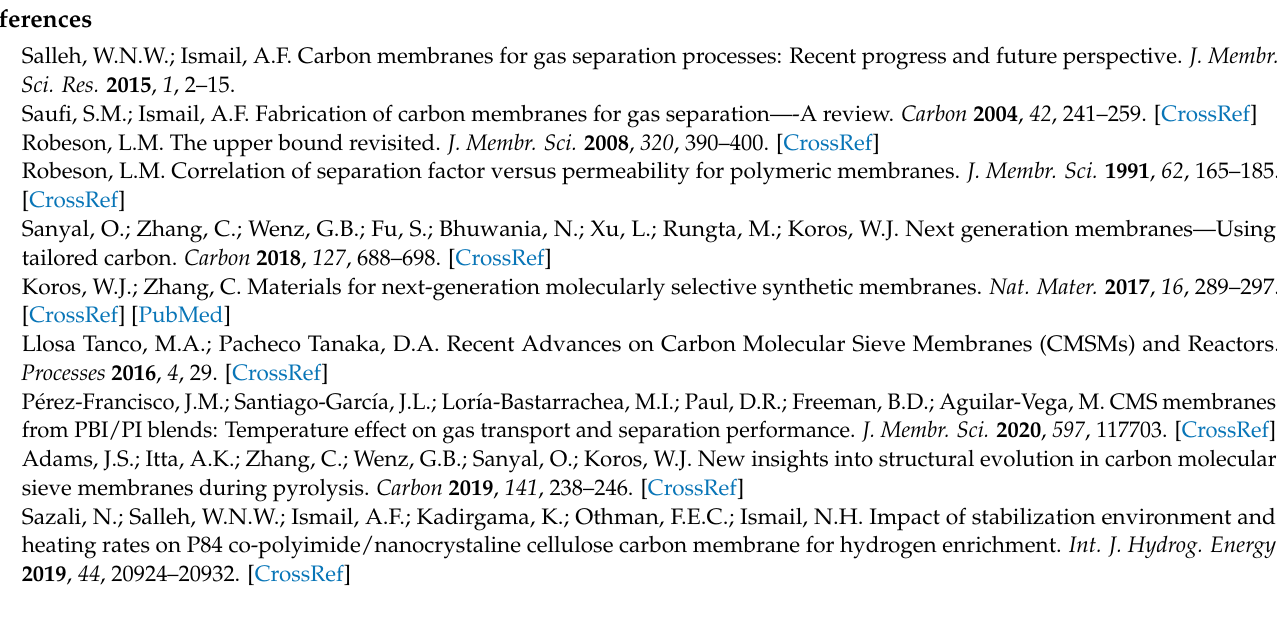
350 ◦ C; (b) 600 ◦ C, Figure S4: Pore size distribution curves: (a) PI and CA1 based on N 2 sorption, (b) PI-350 and CA1-350 with the 265 and 221 m 2 /g BET surface area based on CO 2 sorption, respectively, Figure S5: N 2 sorption isotherms curves of CA-350, Figure S6: N 2 sorption isotherms curves of CA-600 and PI-600, Figure S7: I D /I G of PI-600, CA1-600, and CA10-600 membranes, Figure S8: The wide-angle XRD patterns of CA-600, Figure S9: Separation performance for H 2 of the